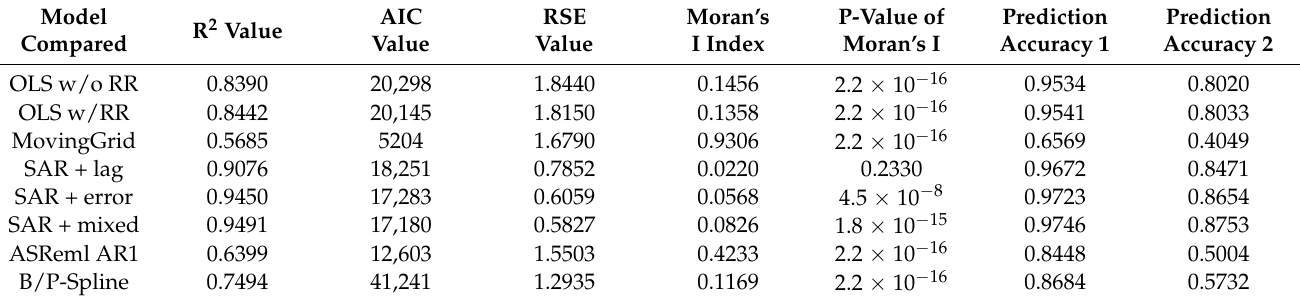
Table 8. Summary of the comparison results among the eight models via R 2 , AIC, residual standard errors, prediction accuracy, and Moran’s I index from data set 3. The most desirable values in each column are highlighted.